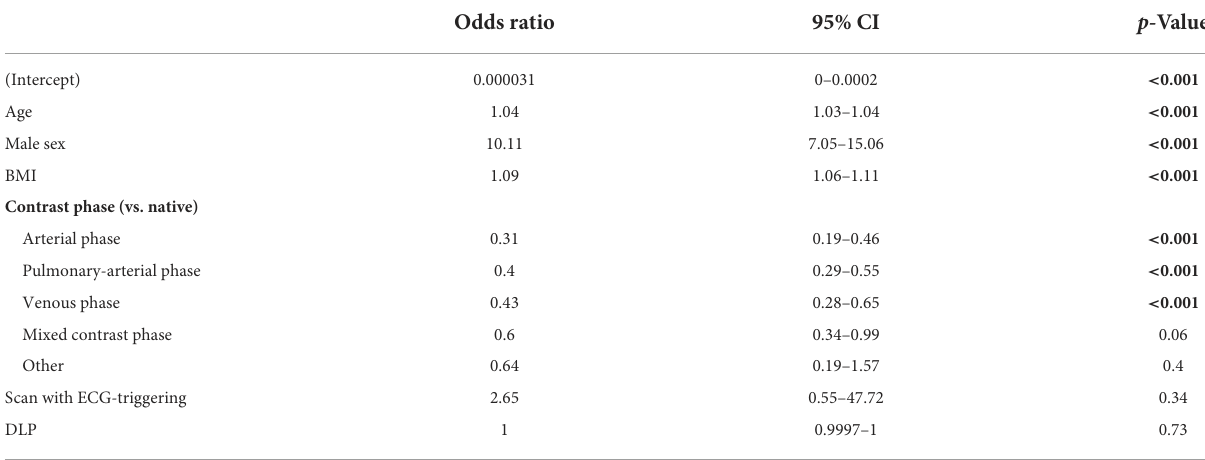
TABLE 4 MLRM Model 1 to differentiate between AIRad_positive vs.